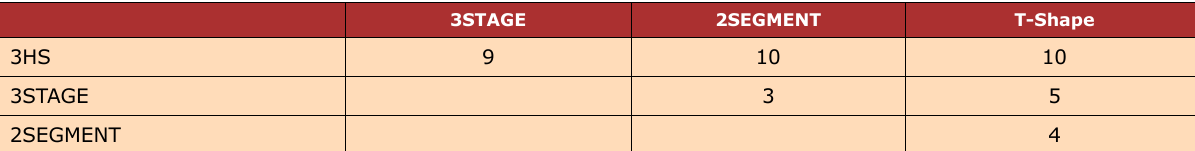
Table 4. The better number problem of different